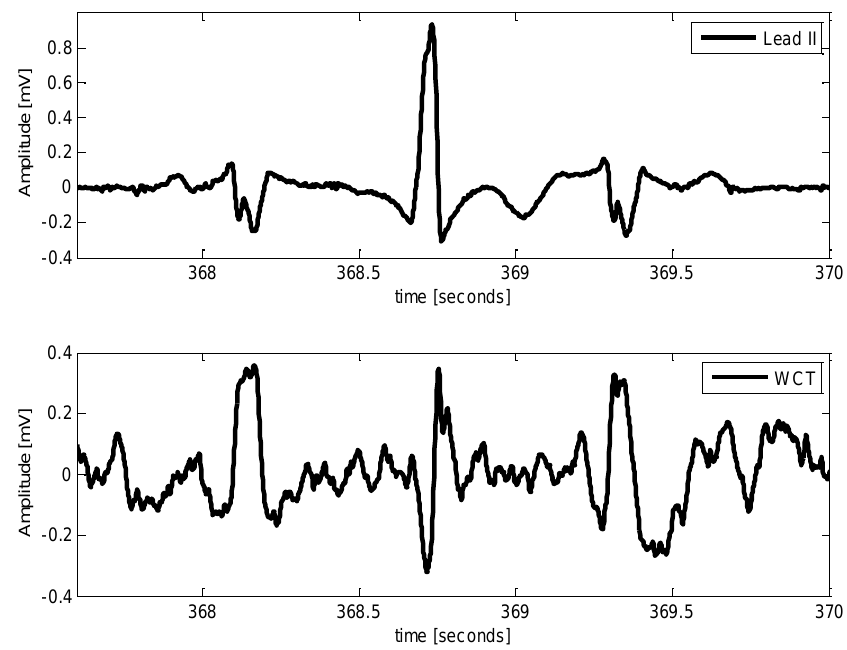
Figure 7. Example of positive WCT that mutates into almost neutral (almost identical value for positive and negative peak) during an ectopic beat (noted by the arrow). WCT amplitude also varies from >100% of lead II amplitude (average) to approximately 50% of lead II during the ectopic beat; recording is from an 85-year-old male patient admitted from the emergency department with severe chest pain and unconfirmed myocardial infarction.